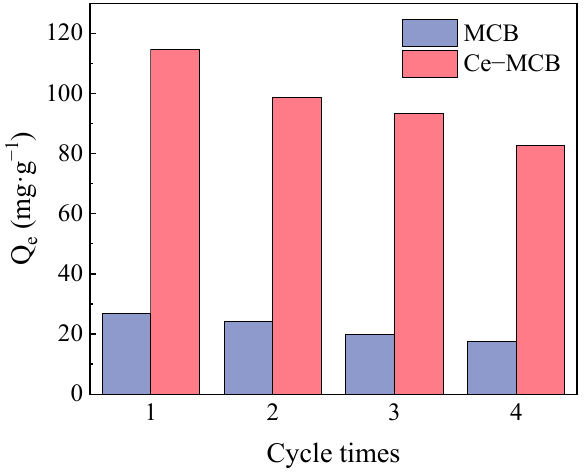
Figure 15. Regeneration of Pb 2+ absorption on magnetic biochars.